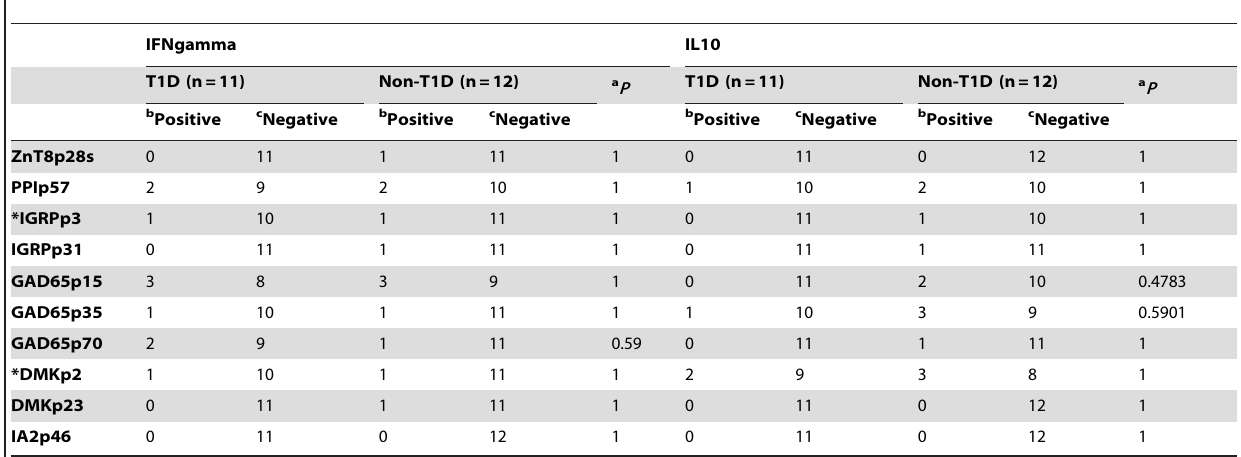
Table 4. Beta-cell epitope specific T cell responses with 95% confidence correction ( 2 log[ p ] $ 1.30).